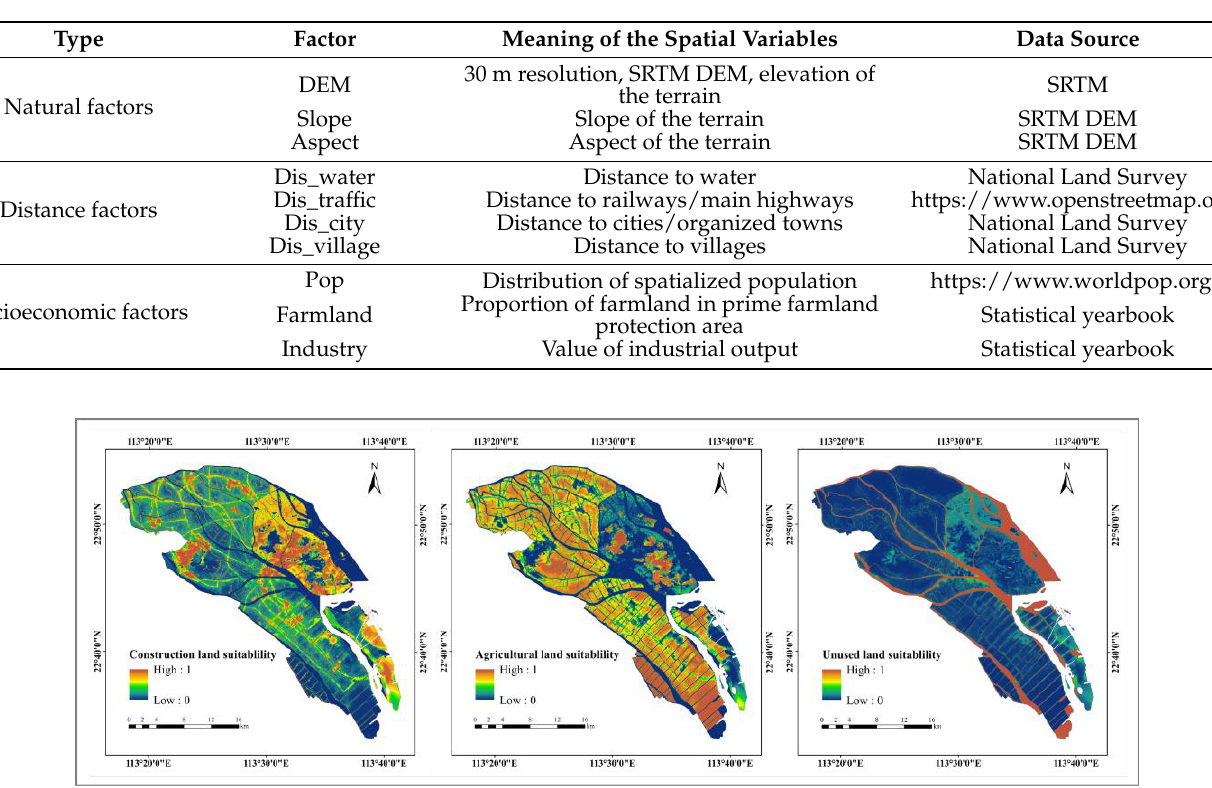
Table 4. The meaning and data source of each driving factor in 2014, 2019, and 2020.